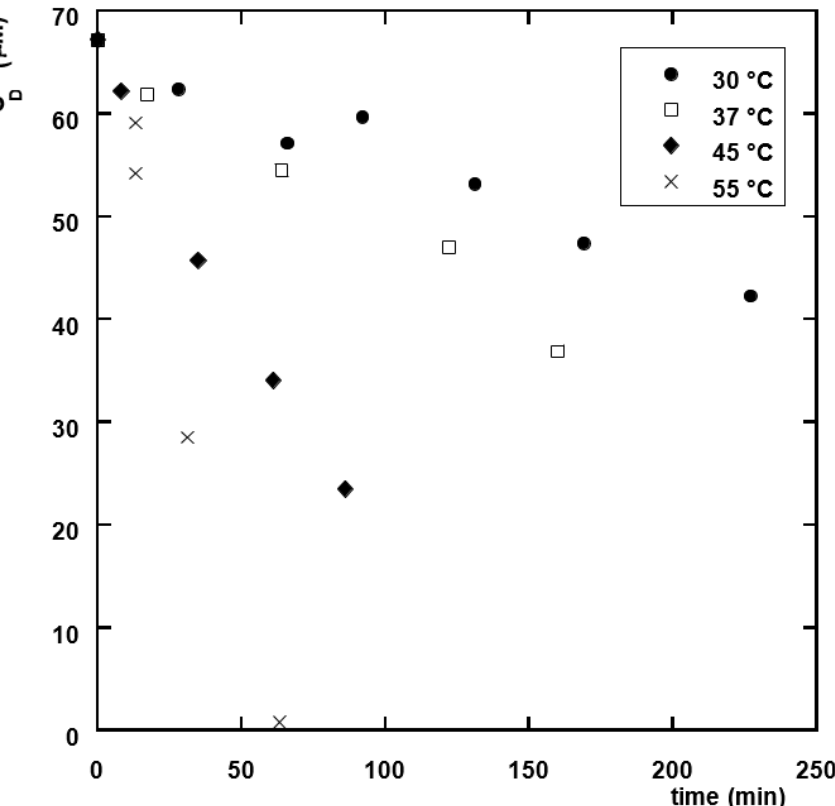
Figure 7. Diuron degradation kinetics profiles in the co-presence of MnO 2 (2.4 g L −1 ) and PDS (4.5 g L −1 ) at different temperatures; initial pH = 3.6.